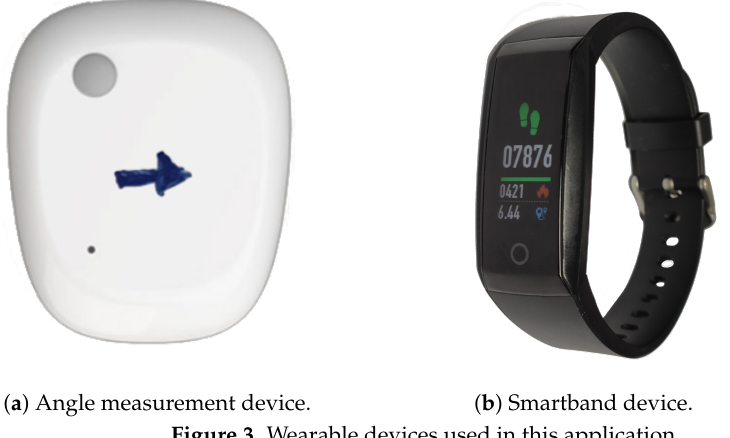
Figure 3. Wearable devices used in this application.